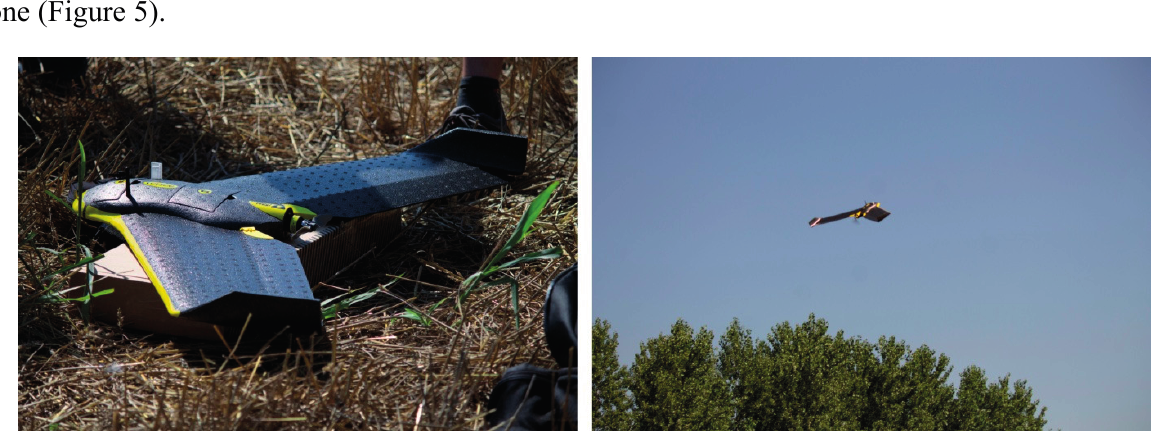
Figure 5. The eBee fixed-wing platform ( left ) and take-off phase ( right